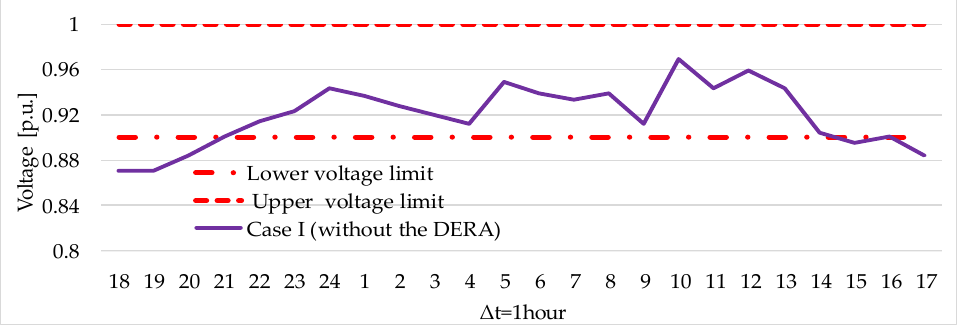
Figure 11. Minimum and maximum voltages for Case I without the DERA coordination strategy.